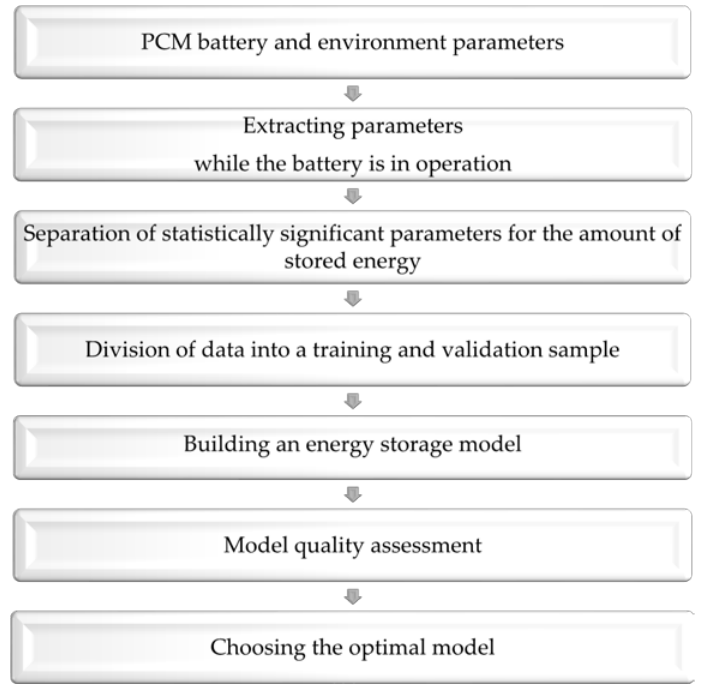
Figure 7. Block diagram of the model for estimating the amount of energy stored in the battery.